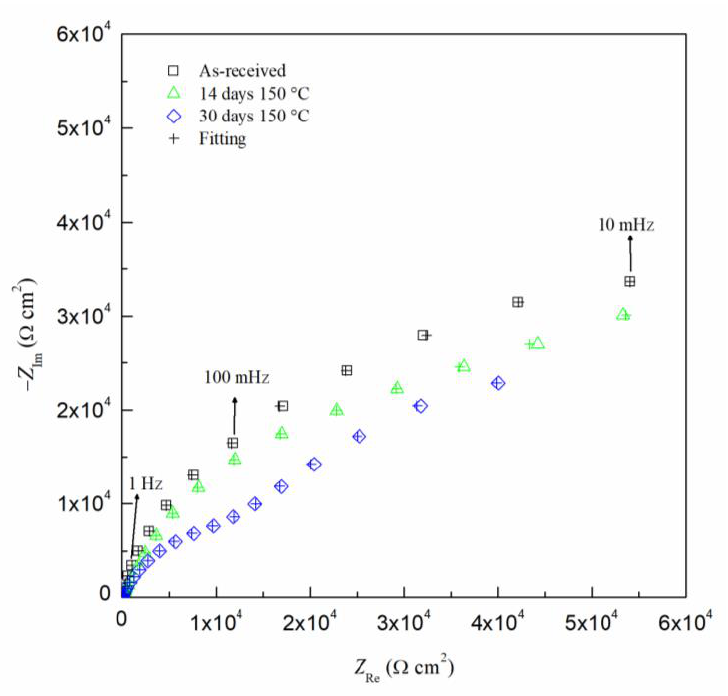
Figure 9. Nyquist plot for AA5083 in 3.5 wt% NaCl sensitized at 150 ◦ C for 0, 14 and 30 days. Cross marks represent EIS fitting results using EEC.